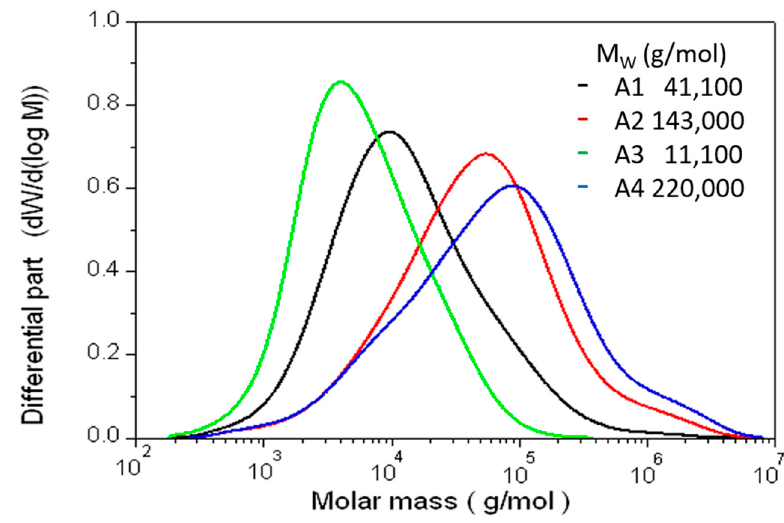
Figure 7. Molecular mass distribution of arabinoxylan products obtained by hydrothermal extraction at laboratory-scale. The four products shown were obtained by the following methods: A1: 1 h, 160 ◦ C, 6.5 bar; A2: 1 h, 150 ◦ C, 4.4 bar; A3: 2 h, 160 ◦ C, 6.5 bar; and A4: 0.5 h, 150 ◦ C, 4.4 bar.